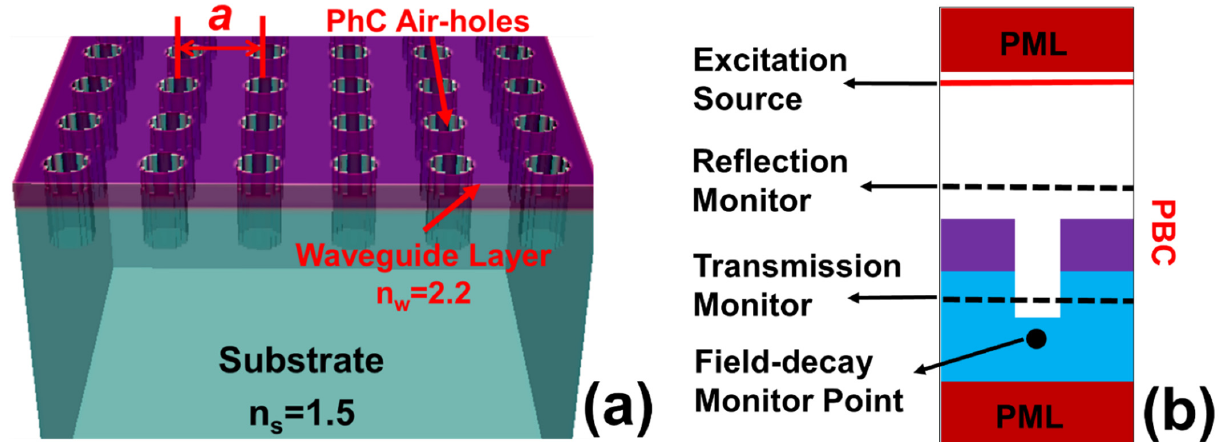
Figure 1. Numerical simulation model of the proposed thermal sensing device: ( a ) A 3D model of the sensor device with an indication of the substrate, waveguide layer, air holes, and lattice constant; ( b ) Unit cell simulation model with an indication of boundary conditions, excitation source, field monitor layer, and PhC structure.